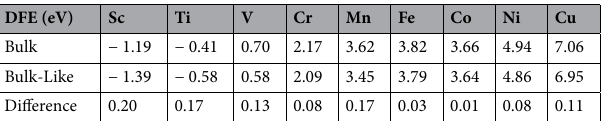
Table 1. Defect formation energy for the considered dopants at positions 1–5 in the slab (see Fig. 1).